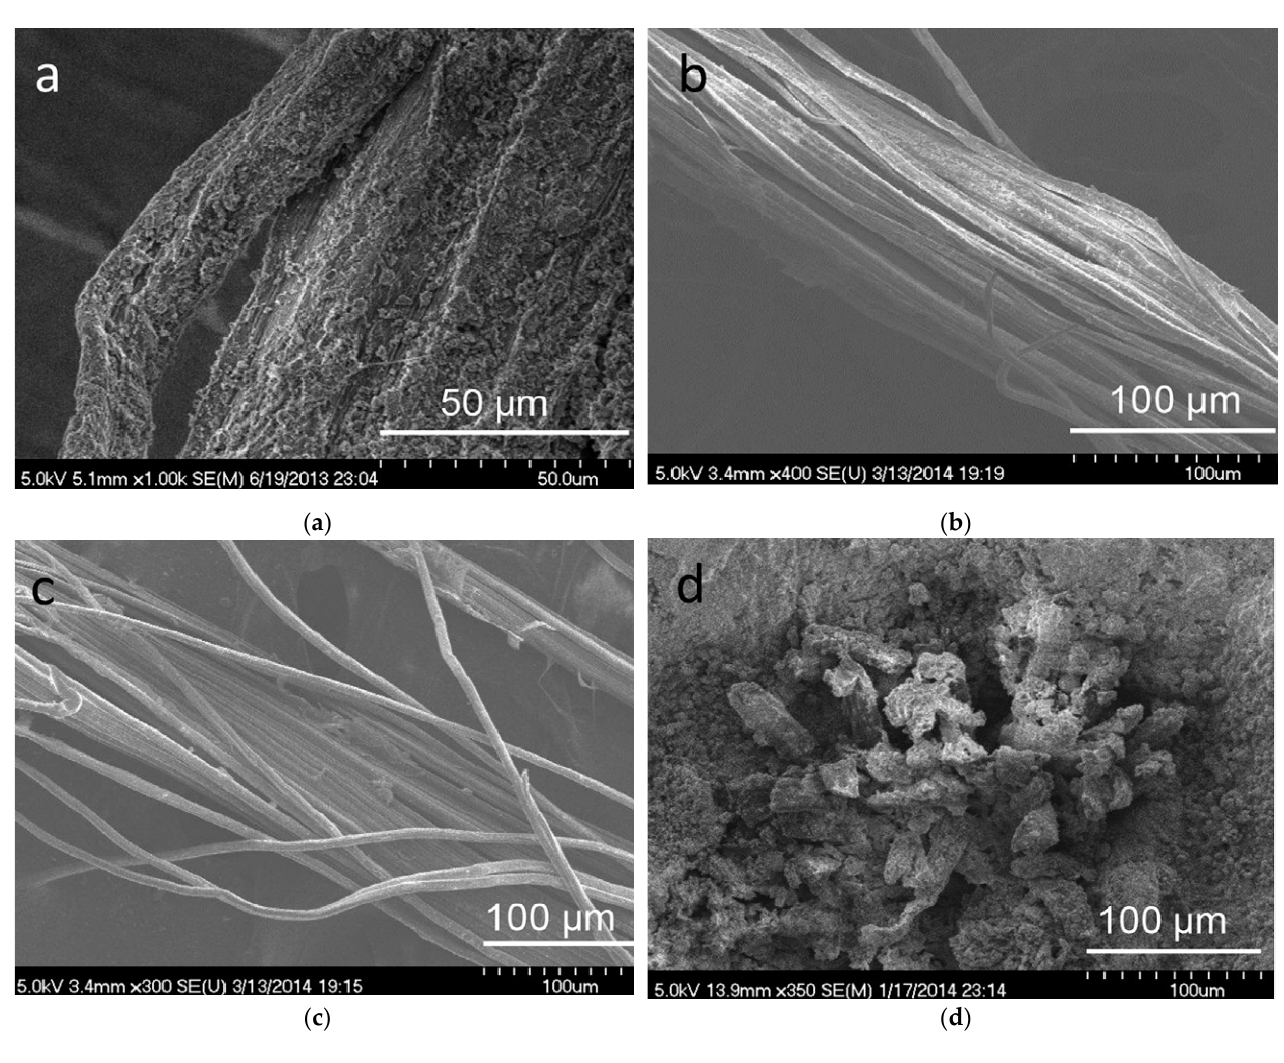
Figure 6. Degradation microstructure of sisal fiber in matrix. ( a ) Degradation of surface lignin, ( b ) Deterioration of hemicellulose, ( c ) Stripping of cellulose, ( d ) Alkaline hydrolysis of cellulose [73].